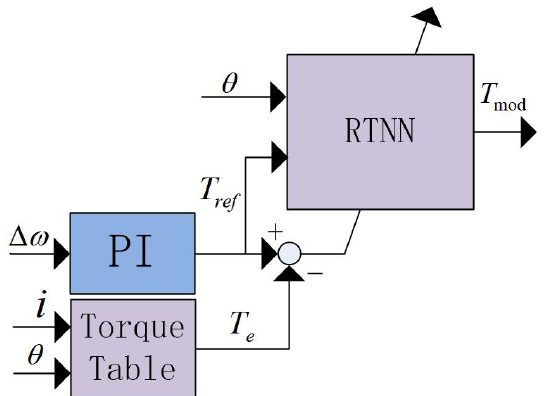
Figure 6. Framework of the